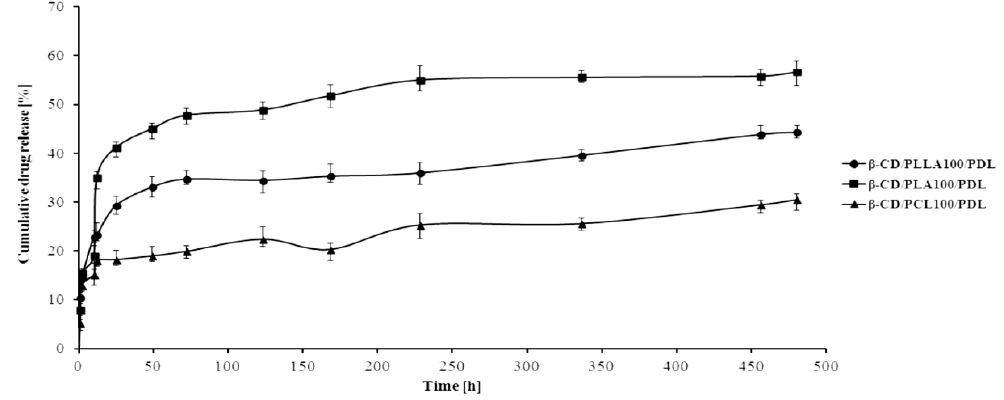
Figure 10. Release profile of PDL from the developed conjugates (pH 7.40 ± 0.05).